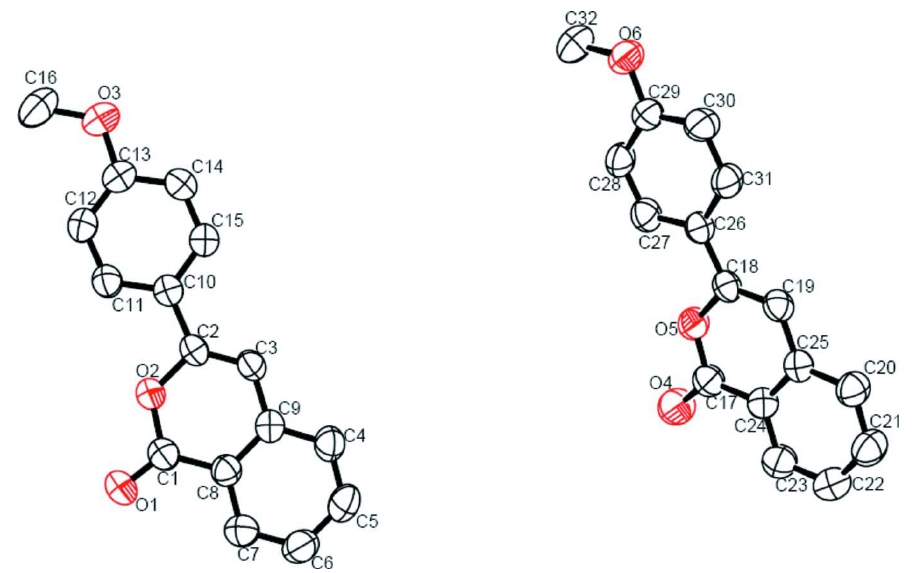
Figure 1 Crystal structure of the title complex, showing 50% probability displacement ellipsoids and the atom-numbering scheme. 3-(4-Methoxyphenyl)-1 H